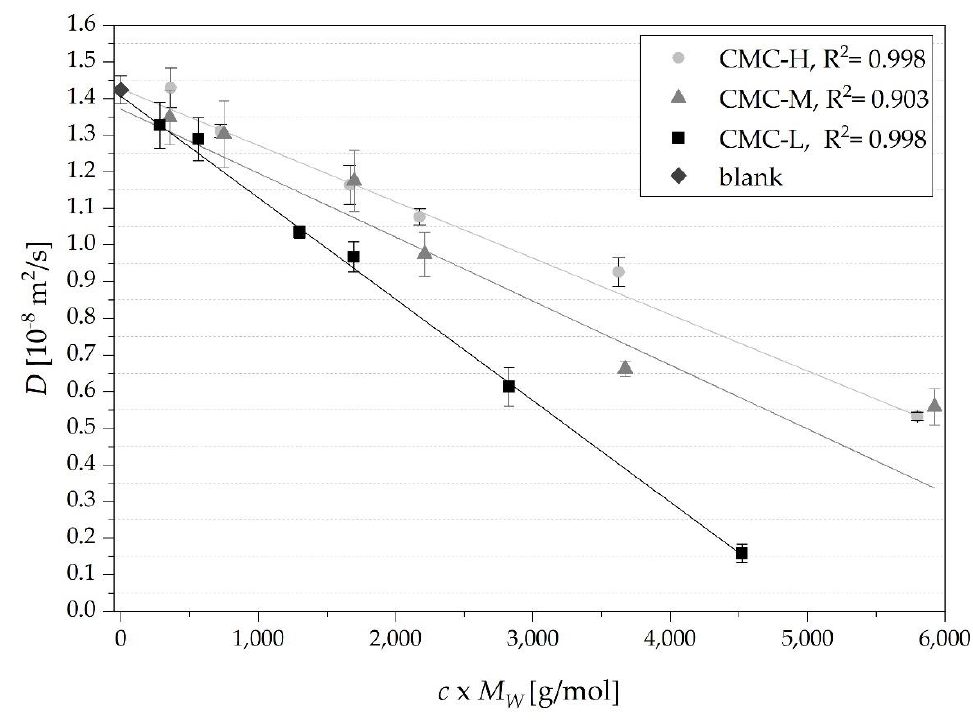
Figure 5. Correlation of diffusion coefficient of glucose in CMC solutions and increasing concentrations × M W of the three different CMC types: CMC-L (100 kDa), CMC-M (395 kDa) and CMC-H (725 kDa). Points correspond to experimental data and lines to fitted data using linear regression (R 2 ≥ 0.903).